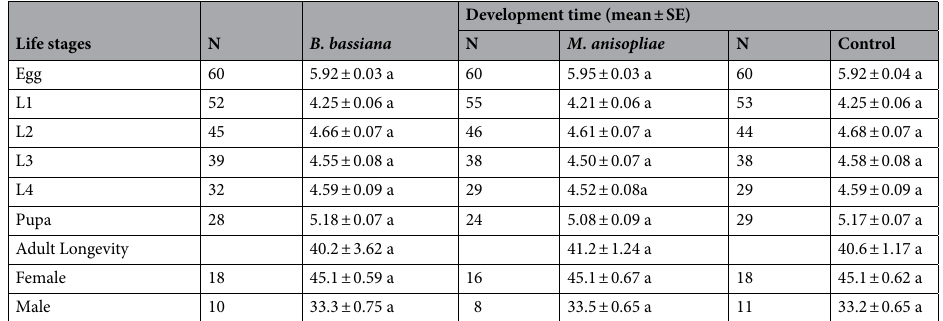
Table 1. Developmental period (days) of Coccinella septumpunctata after exposure of entomopathogenic fungi. SE was estimated by Bootstrapping (100,000 replications), L1–L4 indicate the larval instar, means sharing similar letters in each row are not significantly different at P > 0.05, N = numbers of individual C. septumpunctata that completed a stage.